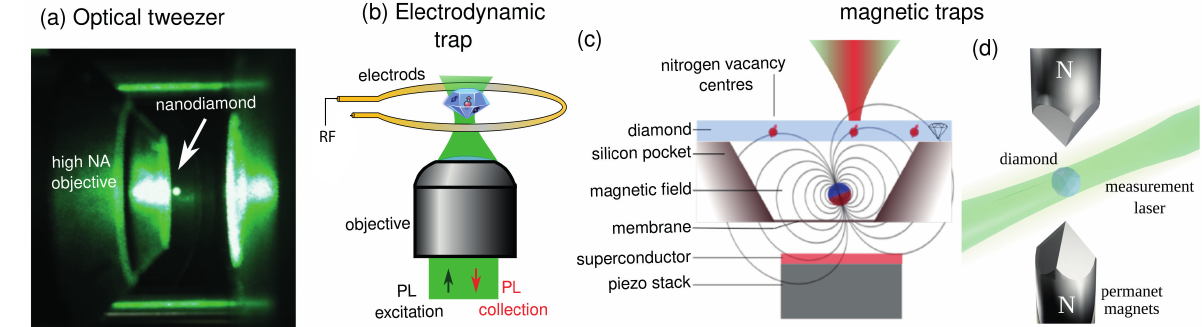
Figure 1. Different approaches to particle levitation. ( a ) Optical tweezers. Picture of an infrared laser focused through a high numerical aperture (NA) objective (shown on the left) allowing trapping a nanodiamond at its focus. The efficient scattering of the green laser used for NV excitation enables one to see the nanodiamond with the naked eye. ( b ) Paul trap: a charged diamond particle is held in vacuum by electric field gradients. ( c ) A magnetic particle is levitated above a superconductor. NV − centers implanted in a diamond slab above the levitated particle can be coupled with its motion through the magnetic field gradient. Adapted from ref. [35]. ( d ) A diamond particle is trapped by large magnetic field gradients thanks to its